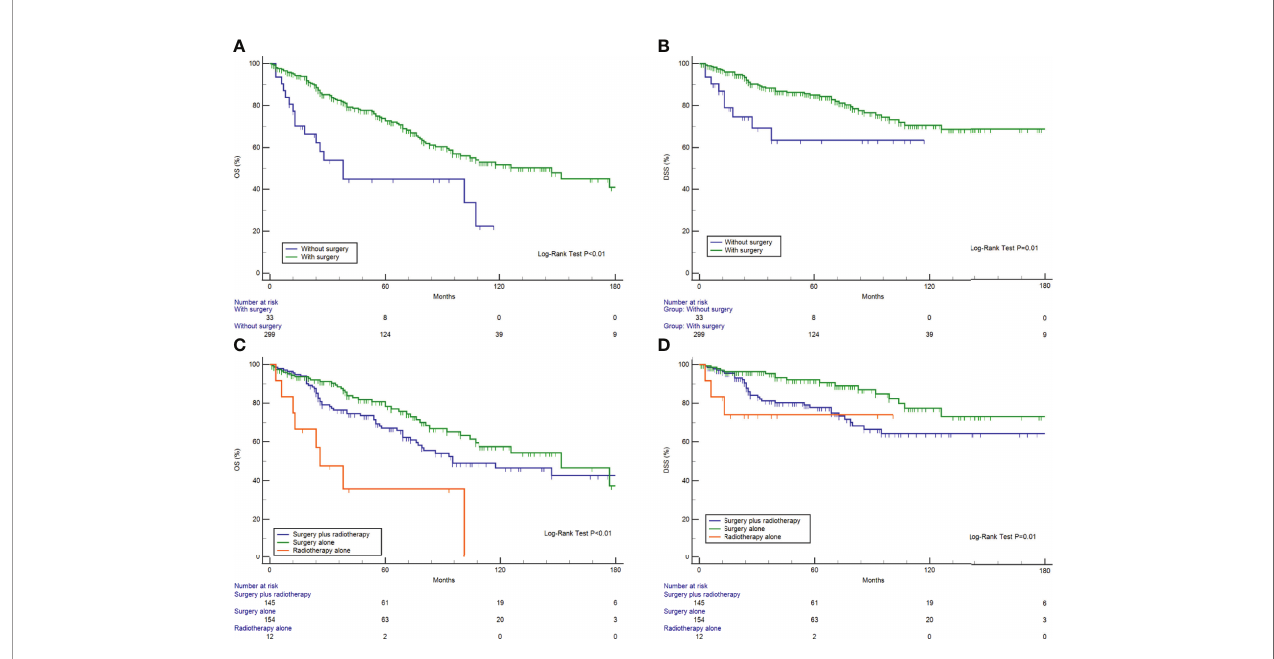
FIGURE 3 | Survival analysis strati fi ed by surgery (A , B) and treatment modalities (C , D) .